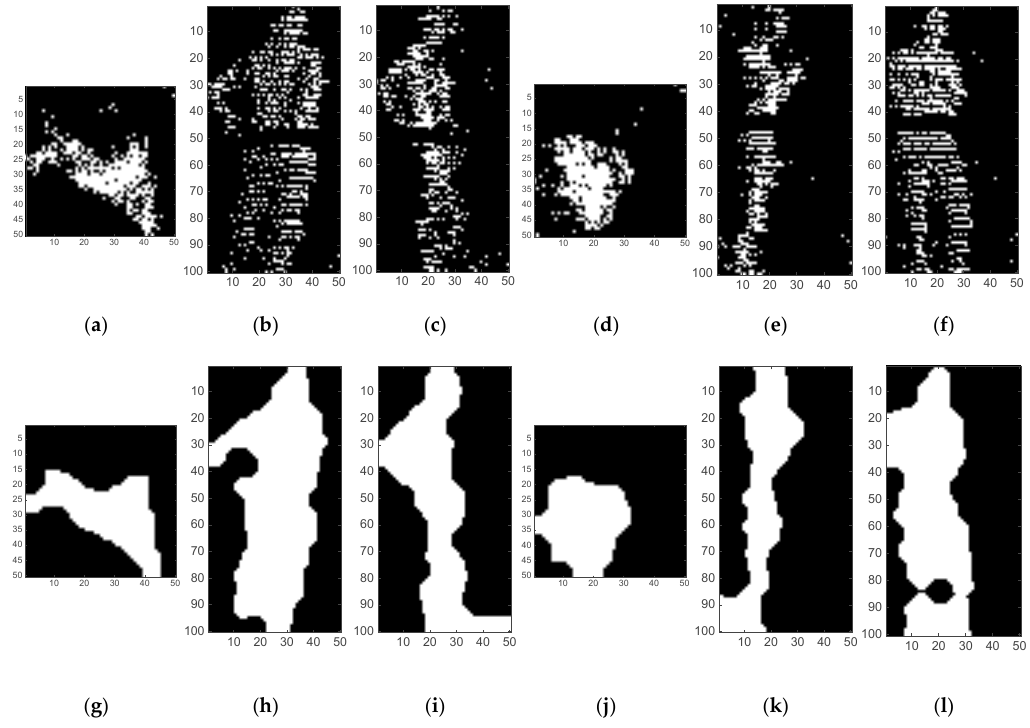
Figure 8. ( a – f ) binary images generated from the XY, XZ and YZ projections of two pedestrian samples; ( g – l ) results of the pre-processing of the binary images.